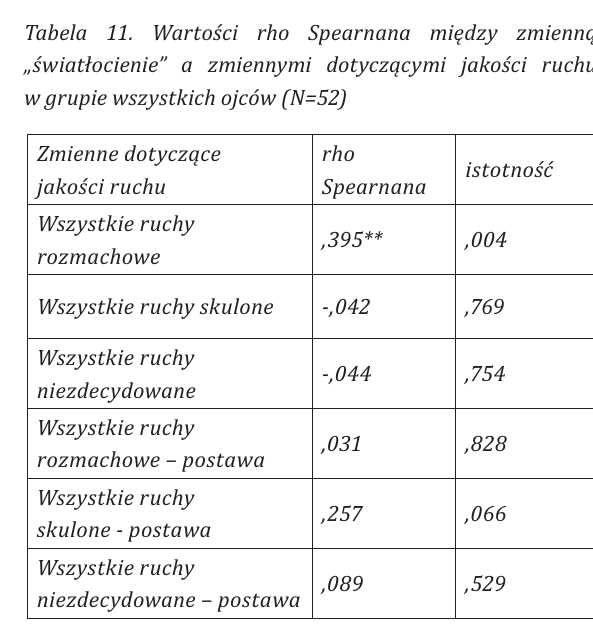
Tabela 8. pokazuje, że wystąpiły istotne związki między zmienną „światłocienie” a ruchami rozmachowymi Tabela 9. Wartości rho Spearnana między zmienną „światłocienie” a zmiennymi dotyczącymi jakości ruchu w grupie rodziców chorych dzieci (N=63)